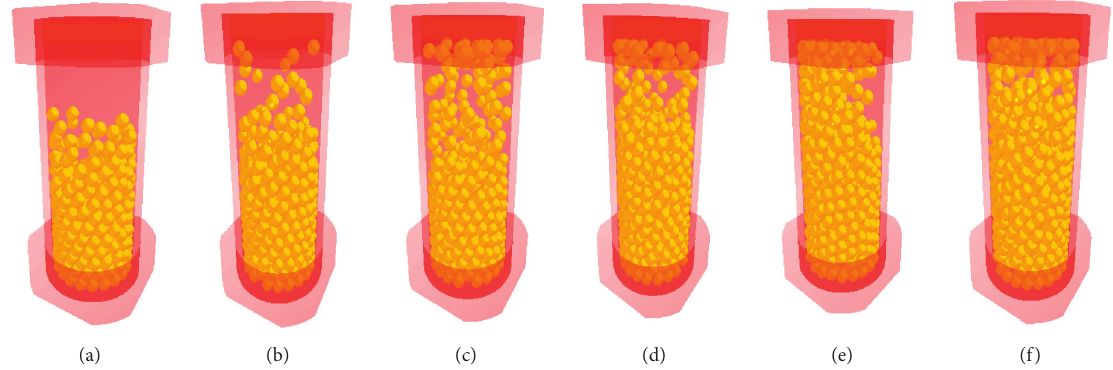
Figure 10: Effect of different particle filling rates. (a) 60%. (b) 70%. (c) 80%. (d) 85%. (e) 90%. (f)